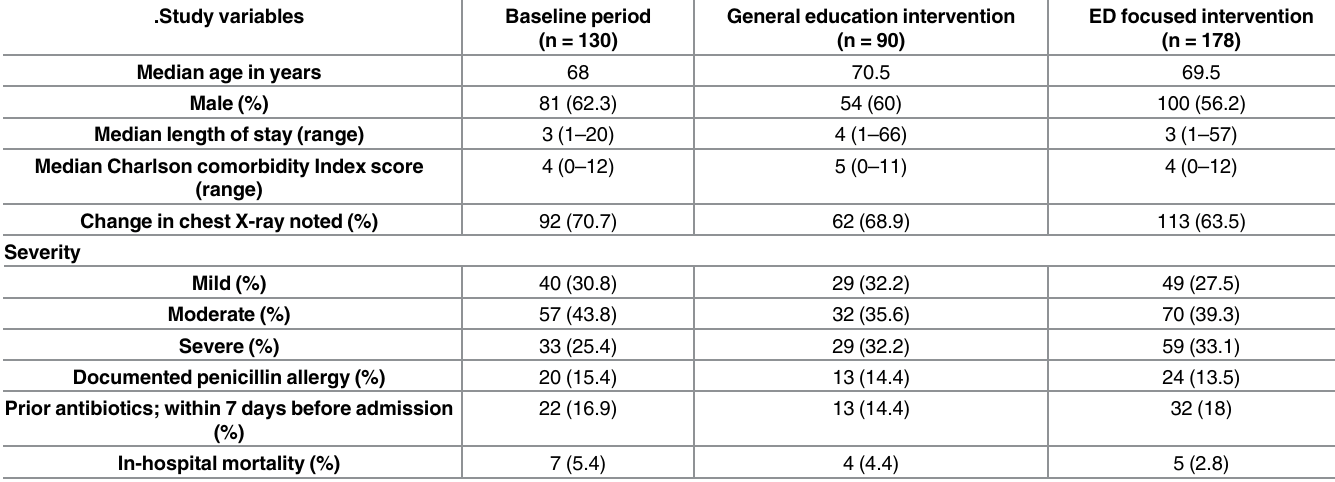
Table 2. Patients ’ demographics and characteristics.